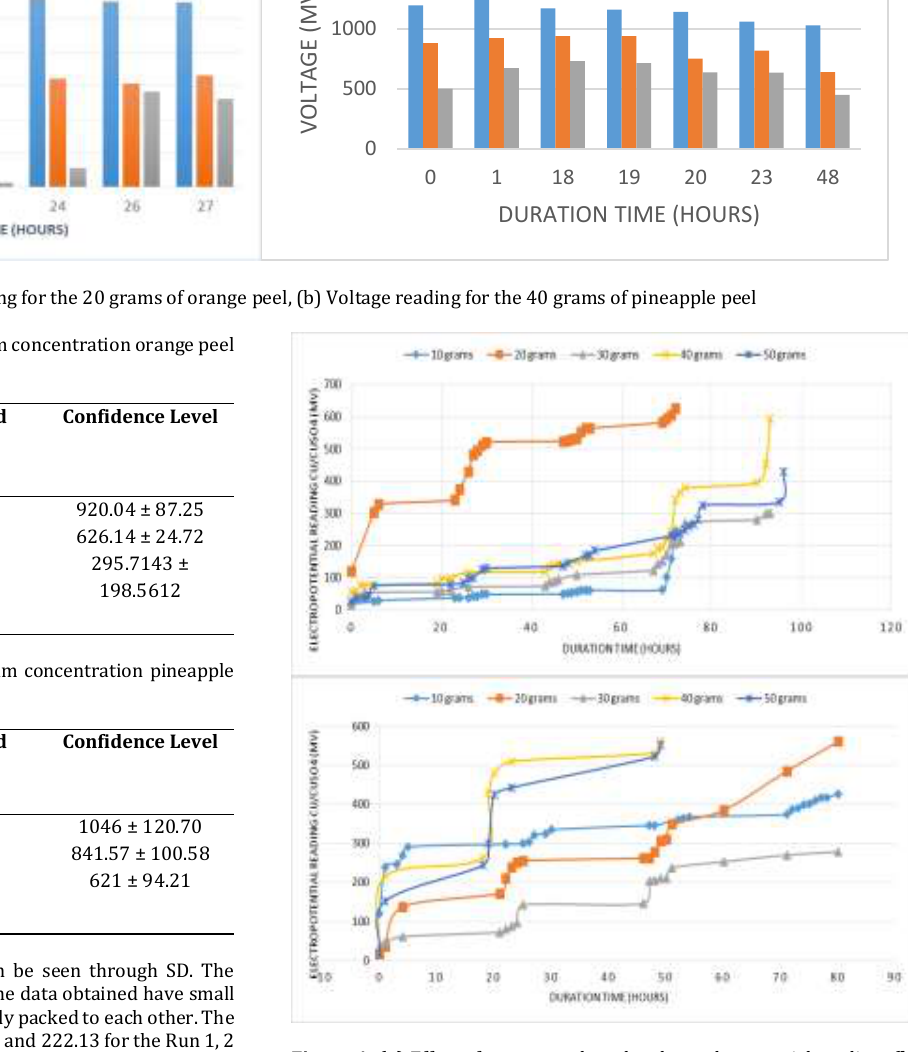
Figure 4: (a) Effect of orange peel on the electrode potential reading, (b) Effect of pineapple peel on the electrode potential